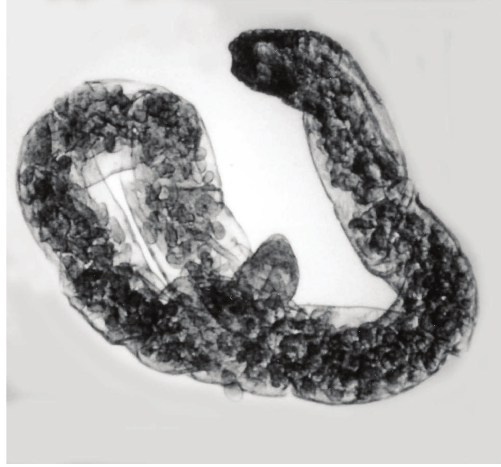
Figure 20: Head of a female of Rabbium paradoxus . Arrow shows anteriorly located